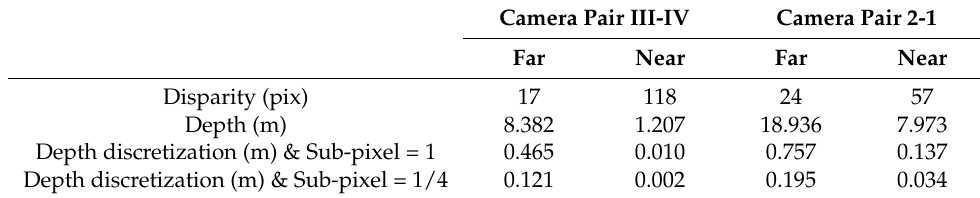
Table 2. Range Field of the remote sensor calculated for the application on advanced safety